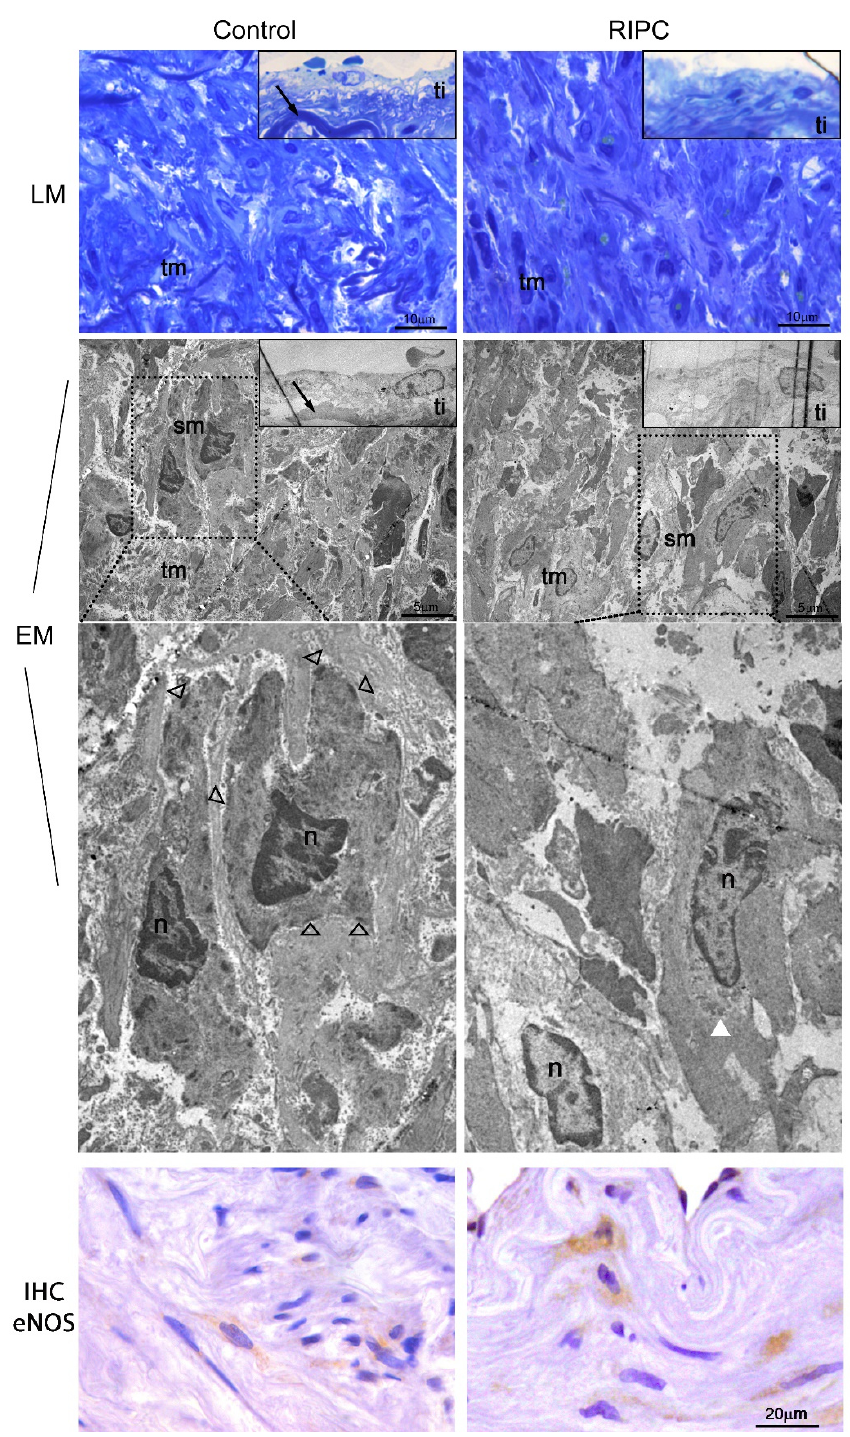
Figure 5. Light (LM) and electron microscopy (EM) of ITA from non-RIPC (control) patients ( left ) and patients with applied RIPC protocol ( right ) during urgent CABG. Semithin sections stained with toluidine blue and corresponding ultrathin sections. Magnified smooth muscle cells showed different phenotypes, contractile in non-RIPC (control) patients ( left ) and relaxed in patients with applied RIPC protocol ( right ). eNOS (IHC eNOS) was found to be highly expressed in relaxed smooth muscle cells. ti-tunica interna; tm-tunica media; sm-smooth muscle cell; arrow-lamina elastica interna; n-nucleus; open arrowhead-dense body and dense plaque; white arrowhead-perinuclear located synthetic organelles. Scale bar: LM-10 μ m, EM-5 μ m, IHC eNOS-20 μ m.